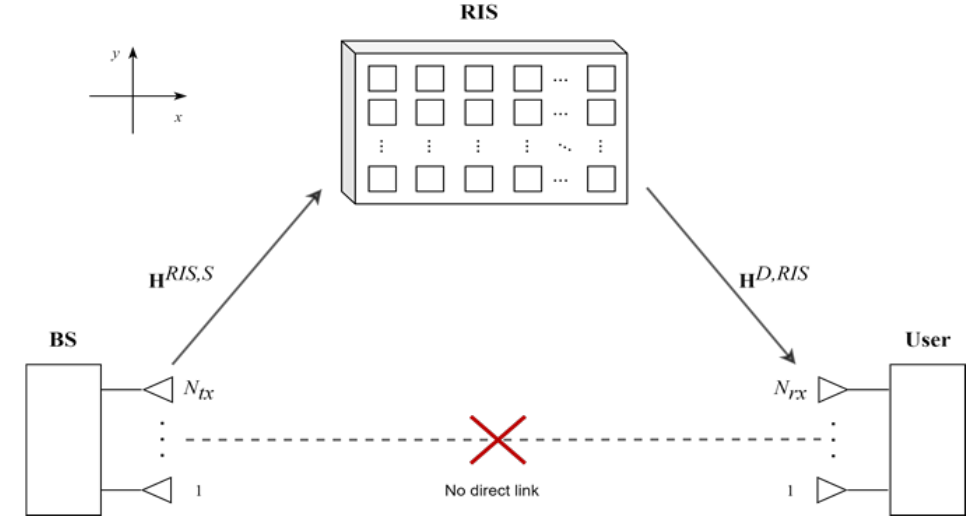
Figure 1. An RIS-assisted UM-MIMO system consisting of a BS, a user, and an RIS with N RIS reflecting elements.